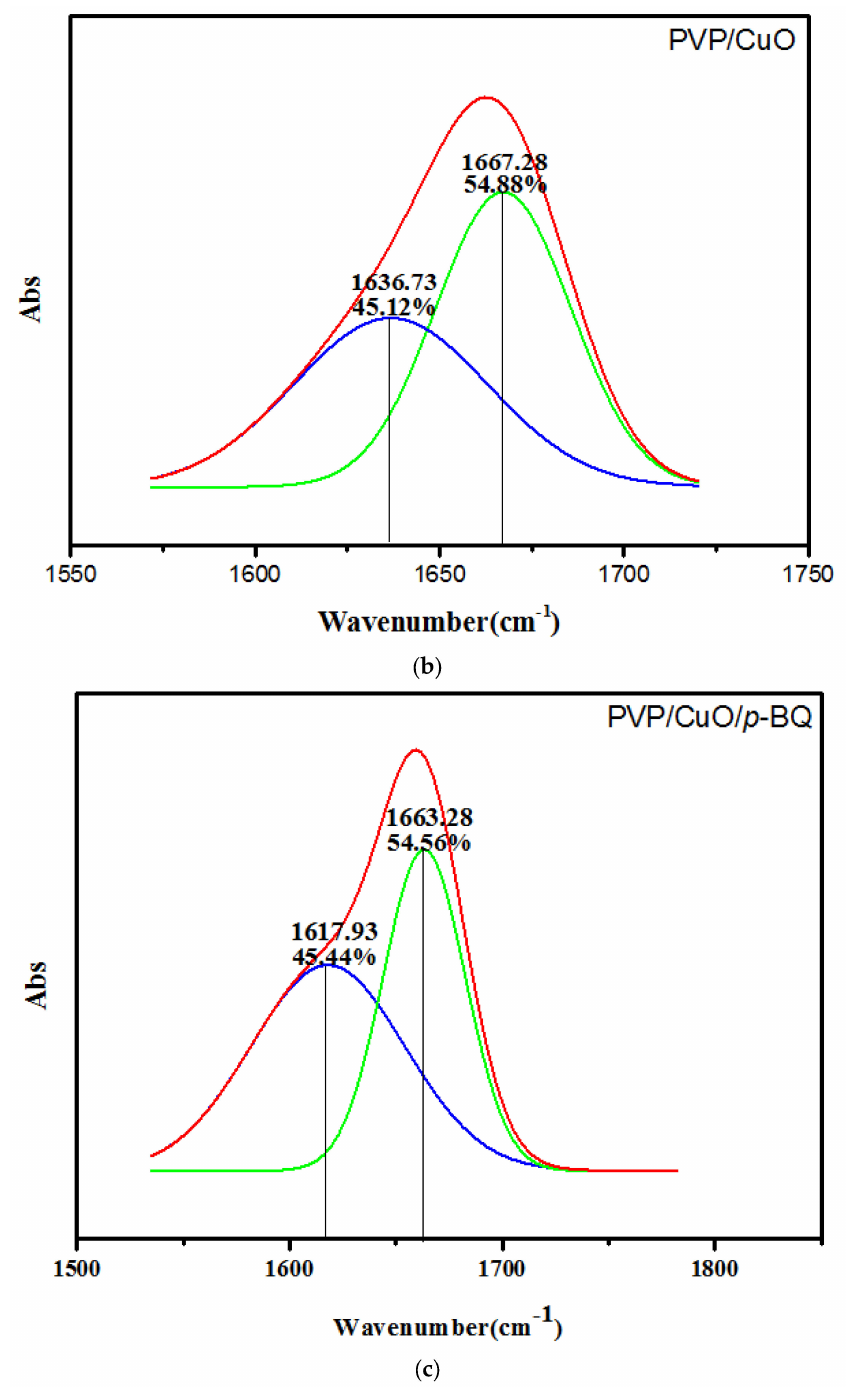
Figure 3. ( a ) Deconvoluted IR spectra of PVP, ( b ) deconvoluted IR spectra of PVP/CuO composite, ( c ) deconvoluted IR spectra of PVP/CuO/ p -BQ